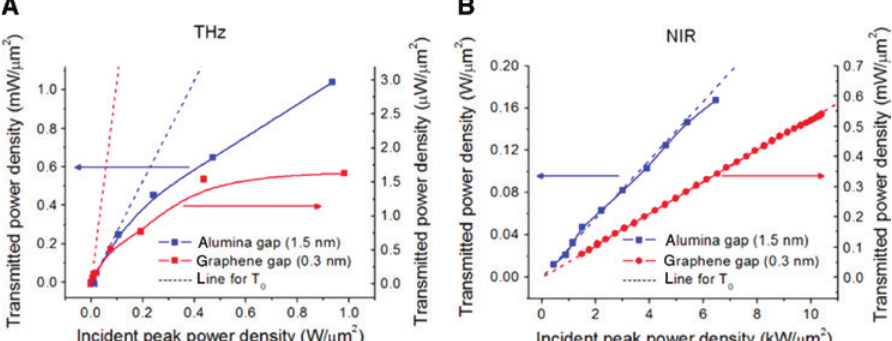
Figure 10: Transmission nonlinearity by electron tunneling in metal gaps. Transmitted peak power densities for 1.5-nm alumina gap and 0.3-nm graphene gap samples as a function of incident peak power densities in frequency of (A) terahertz ( λ ~ 750 μ m) and (B) near IR ( λ ~ 830 nm). Dots indicate the measured values, and dotted lines mean linear regime without tunneling effect. The figures are reproduced from Reference [16].